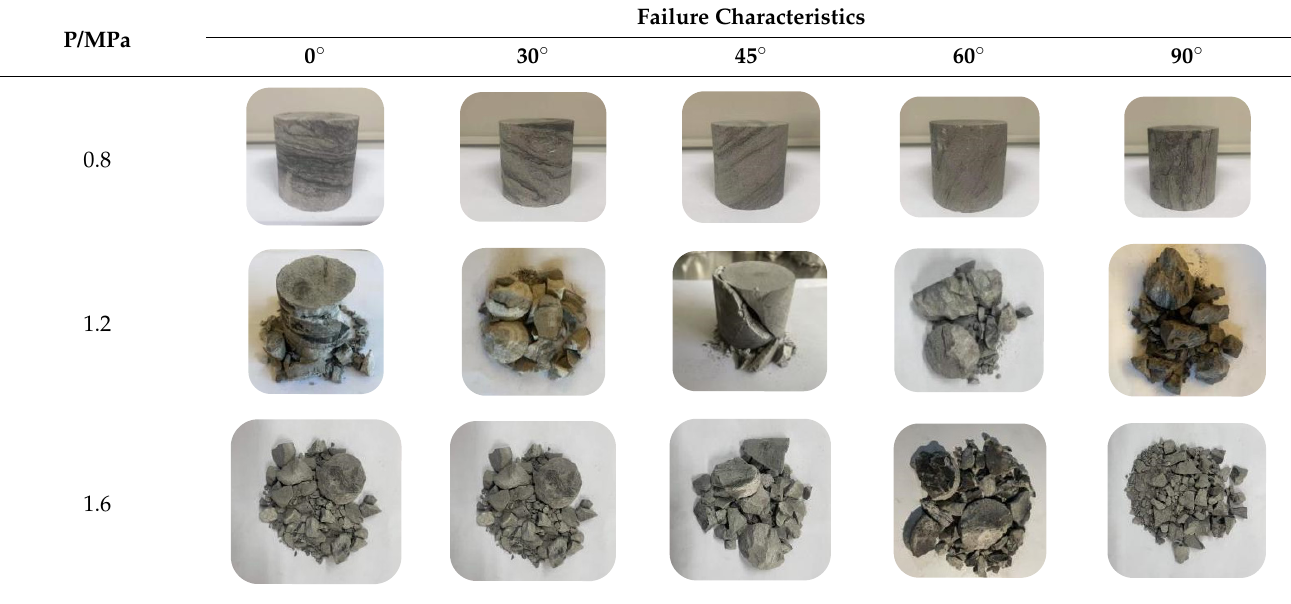
Table 3. Failure characteristics of sandstone.